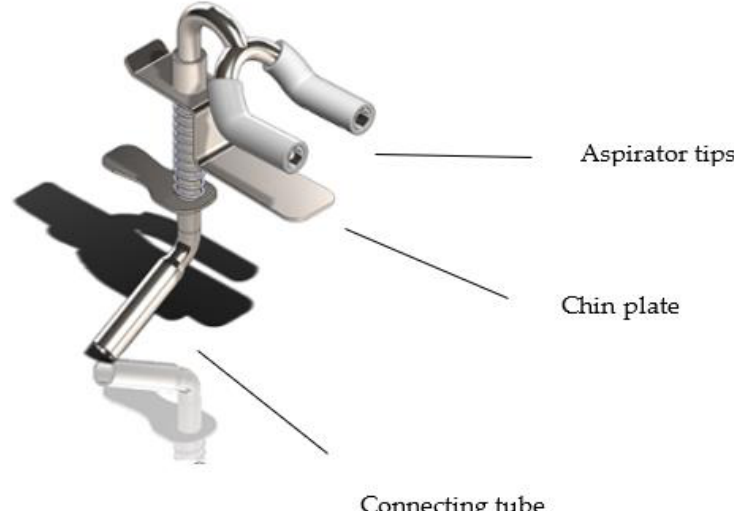
Figure 1. Components of SS-suction.